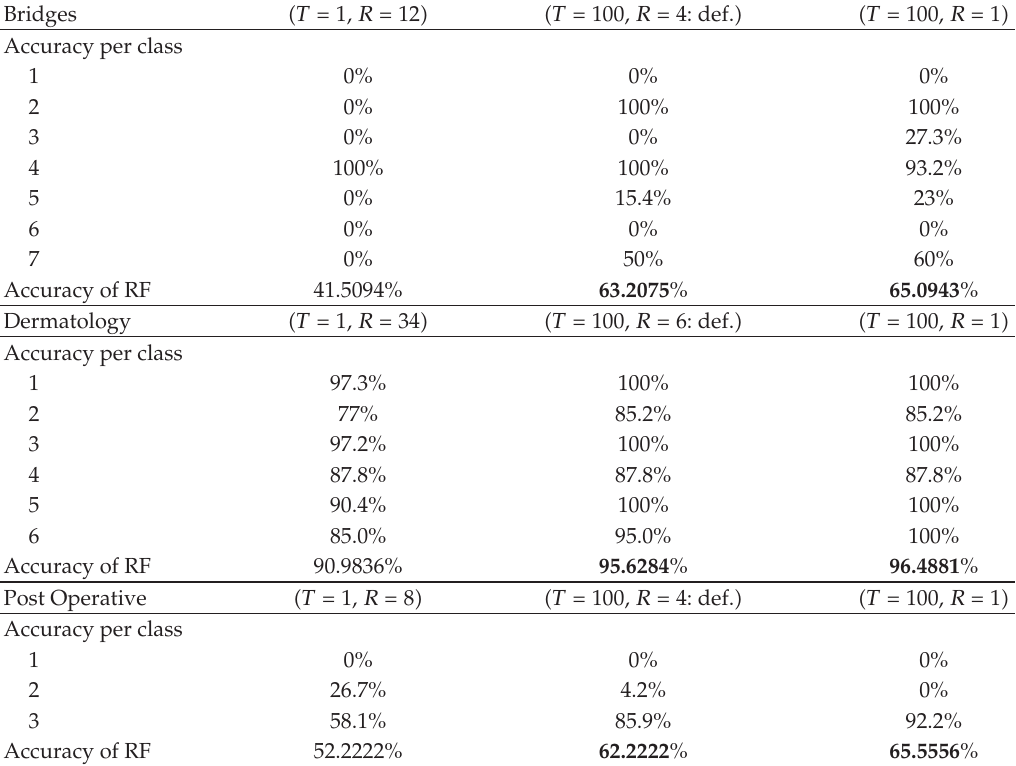
Table 7: The accuracy of trial random forests (cid:6) RF (cid:7) for each class with di ff erent parameters. Bridges